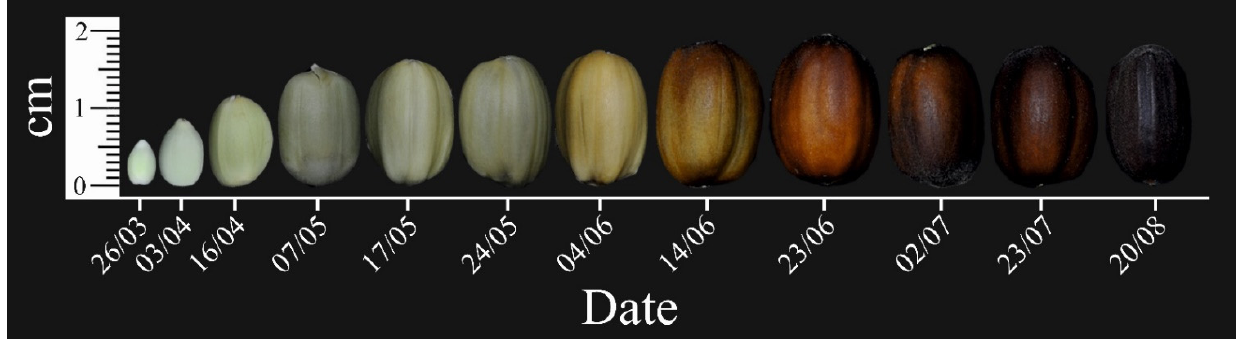
Figure 2. Seed development parameters for cvs. Benzioni (black) and Hazerim (red) in 2017 (solid lines) and 2018 (dashed lines). Fruit mass ( a ), seed mass ( b ), dry seed mass ( c ), and seed water content ( d ) values are the means of 12 seeds. Seed wax content ( e ) and wax mass produced ( f ) were calculated from a sample of 30 seeds. Seed maturation seemed to take place one month earlier in 2018 than in 2017. DW, dry weight.